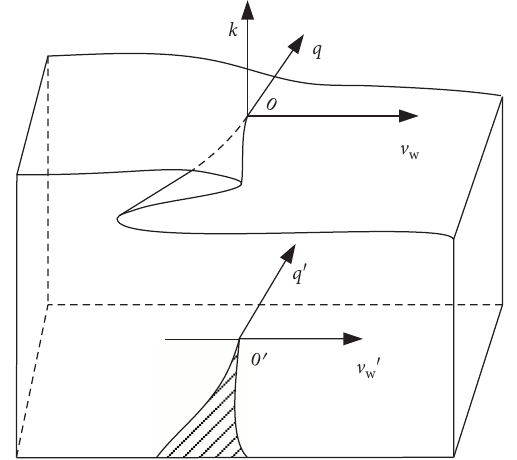
Figure 6: Traffic density cusp catastrophic model equilibrium